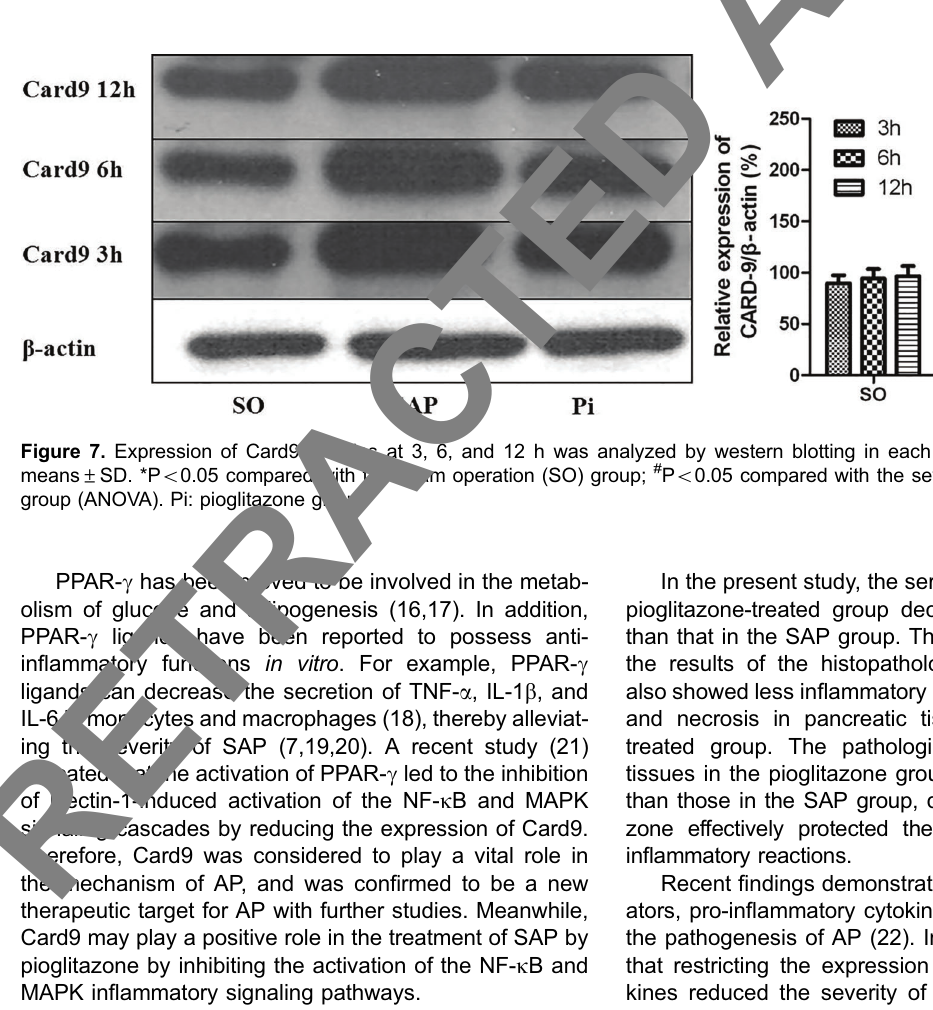
Figure 6. Expression of NF- k B, p38MAPK proteins at 3, 6, and 12 h was analyzed by western blotting in each group. Data are reported as means ± SD. *P o 0.05 compared with the sham operation (SO) group; # P o 0.05 compared with the severe acute pancreatitis (SAP) group (ANOVA). Pi: pioglitazone group.